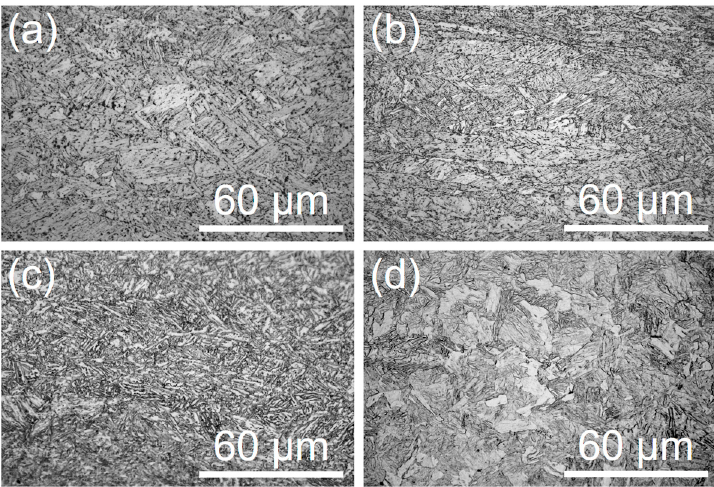
Figure 3. Optical metallography images showing the as-quenched microstructure of NiCu steel after tempering at ( a ) 600 °C, ( b ) 660 °C, ( c ) 720 °C, and ( d ) 780 °C for 1 h.